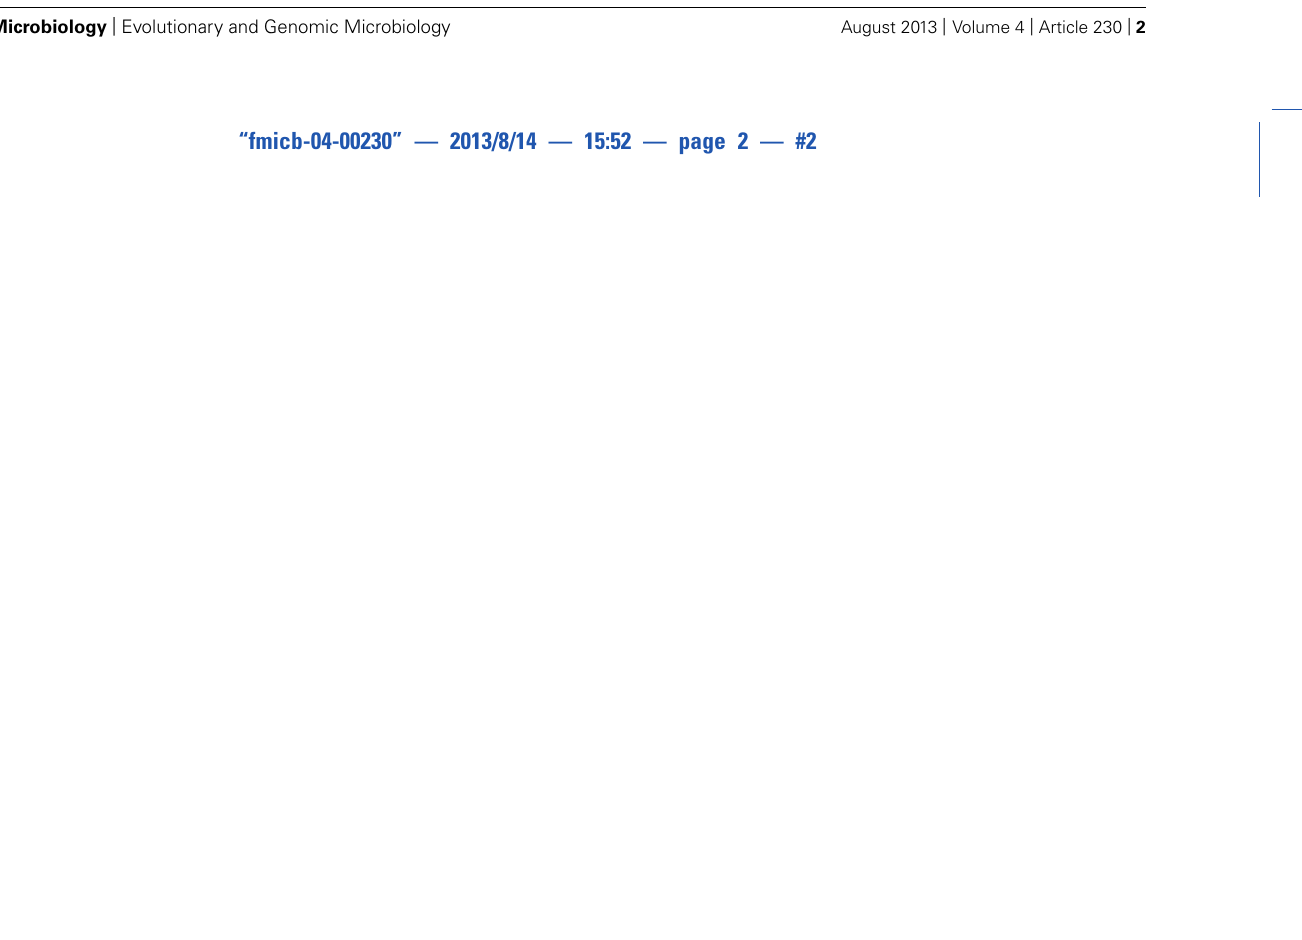
harbor multiple copies of transporter-related genes that are not found in mycoplasmas (Oshima et al., 2004). These genomic fea- tures suggest phytoplasmas are highly dependent on metabolic compounds from their